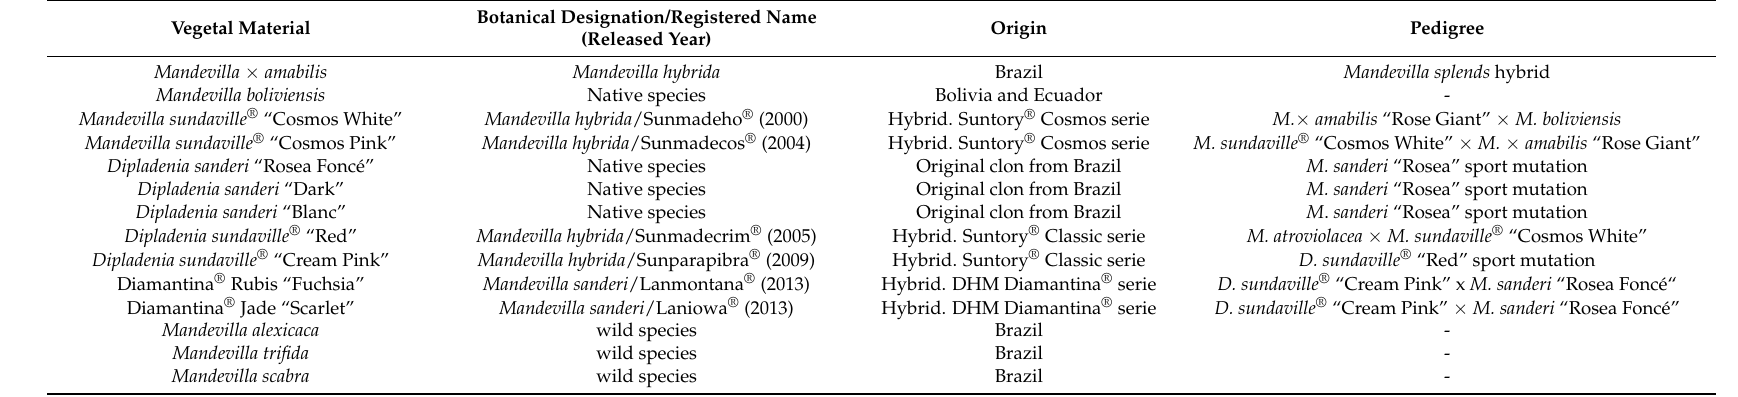
Table 4. Mandevilla genotypes studied in this